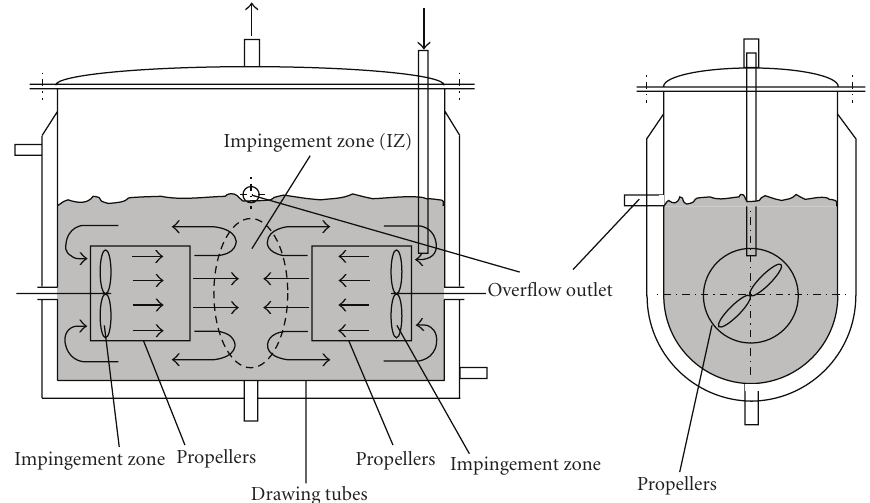
Figure 2: A brief view of SCISR 1-drawing tubes; 2-propellers; 3 impingement zone; 4-overflow outlet IZ-impingement